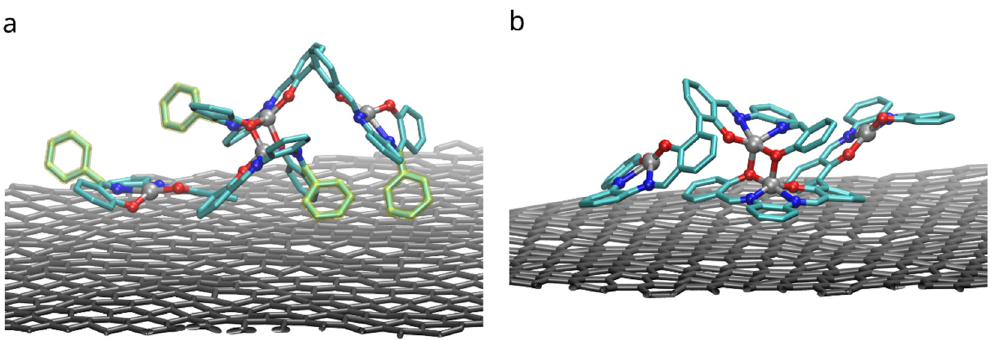
Figure 8. Configurations with the highest adhesion free energy for the dimers of ( a ) the compound A with functional phenyl groups and ( b ) compound B without them. Only upper graphene layer is shown and solvent molecules and compounds hydrogens are omitted for clarity. Phenyl functional groups are highlighted with